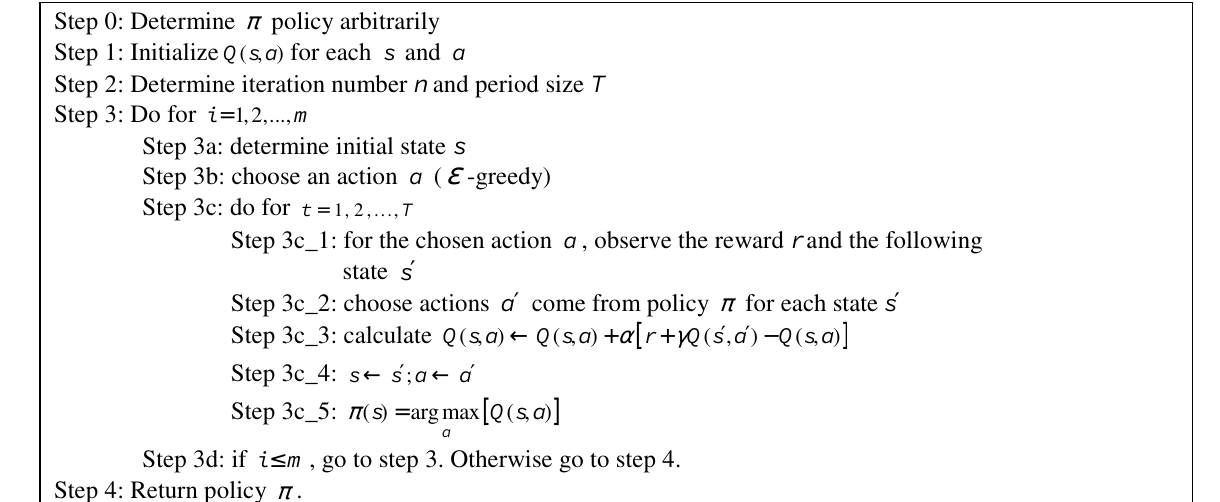
Fig. 1. On-policy TD algorithm :